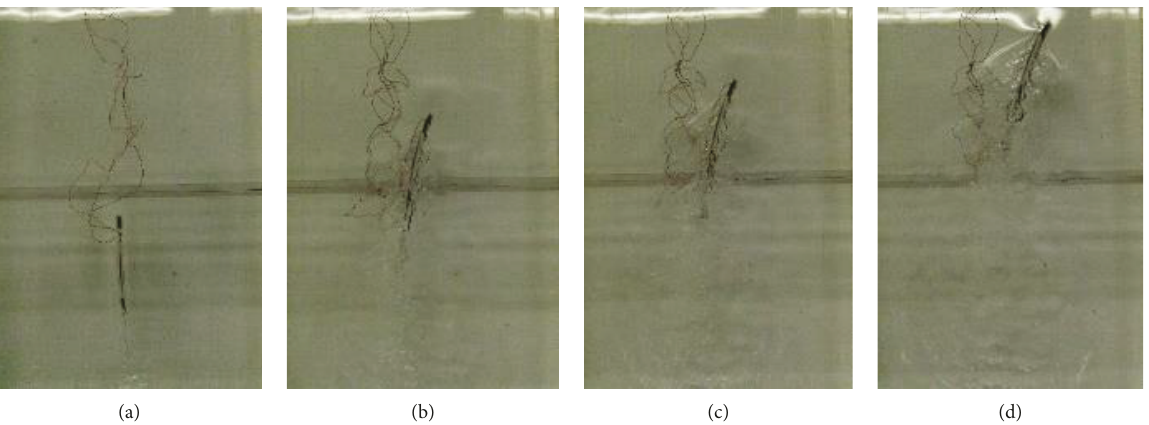
Figure 17: Turning right motion of new soft robot prototype at 15 Hz. (a) T = 0 s. (b) T = 0 3 s. (c) T = 0 4 s. (d) T = 0 6 s.